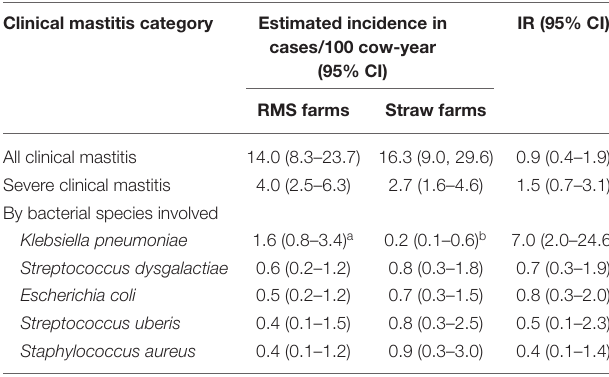
TABLE 3 | Least square means clinical mastitis incidence estimates (in cases/100 cow-year) and incidence ratio (IR) between 26 RMS farms and 60 straw-bedded farms and computed using a binomial negative model.